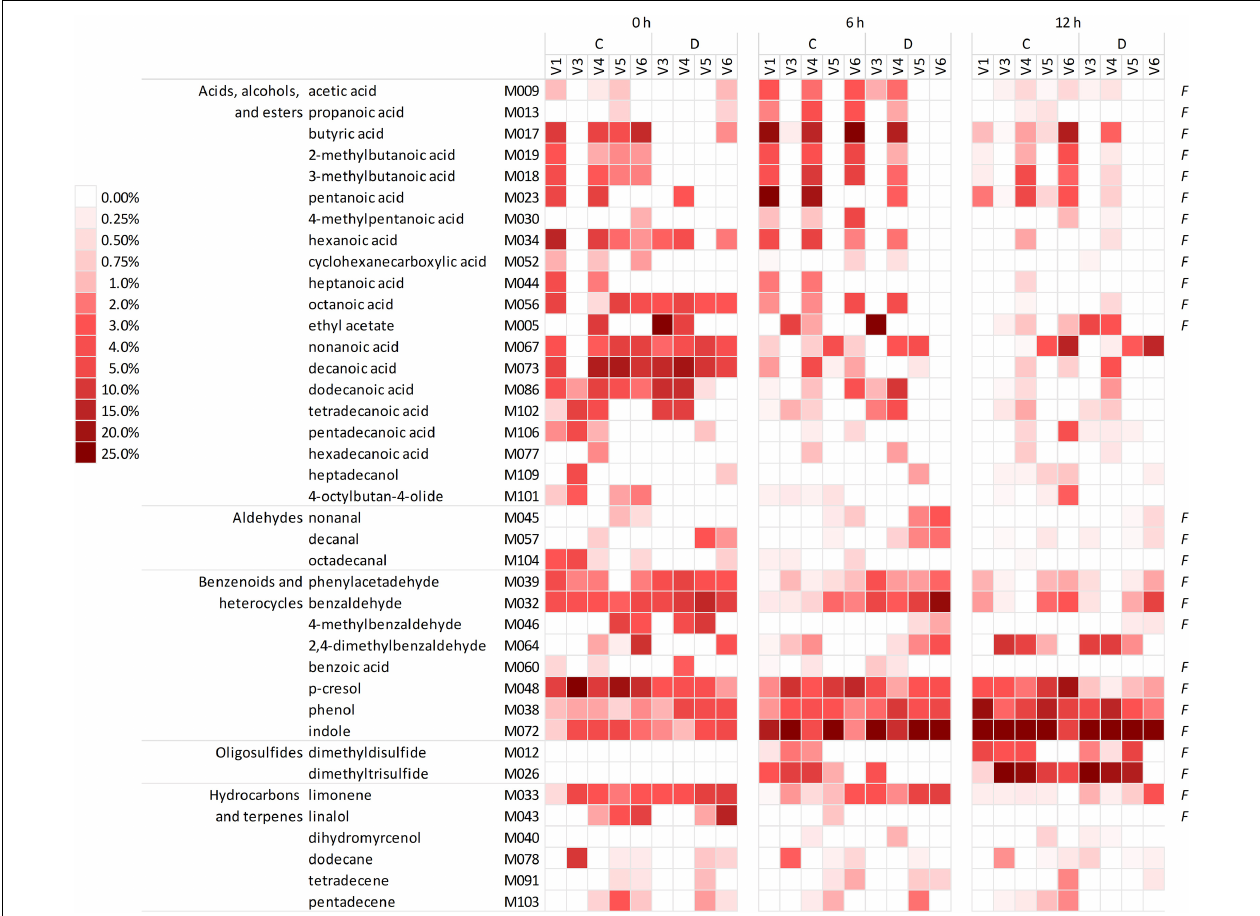
FIGURE 2 | Heatmap of the main VOCs identified in the headspace of microbiota cultures at 0, 6, and 12 h. The shades of red indicate the relative abundance in the gas chromatogram. Only the VOCs occurring at least in five samples and at least once ≥ 1% are reported. F indicates the natural occurrence in the feces of healthy humans, according to de Lacy Costello et al. (2014). VOCs, volatile organic compounds.